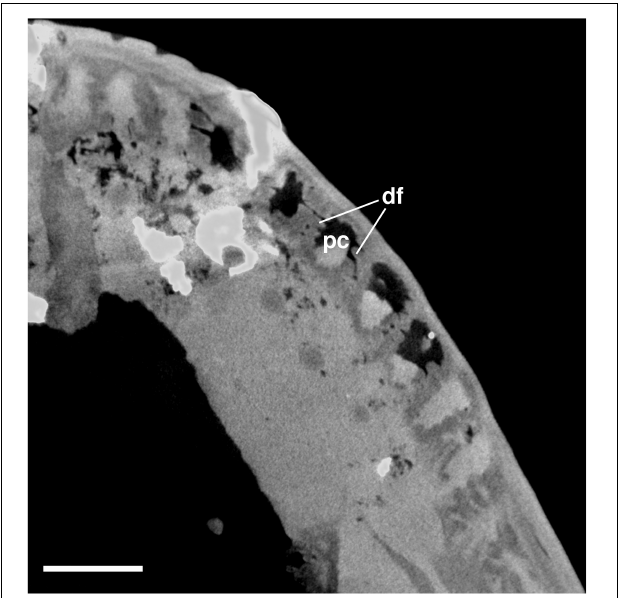
FIGURE 4 | Cross-sectional view of the bases of the upper jaw marginal teeth in Nannaroter mckinziei , OMNH 73107, obtained from CT scans. df, dentine fold; pc, pulp cavity. Scale bar equals 1